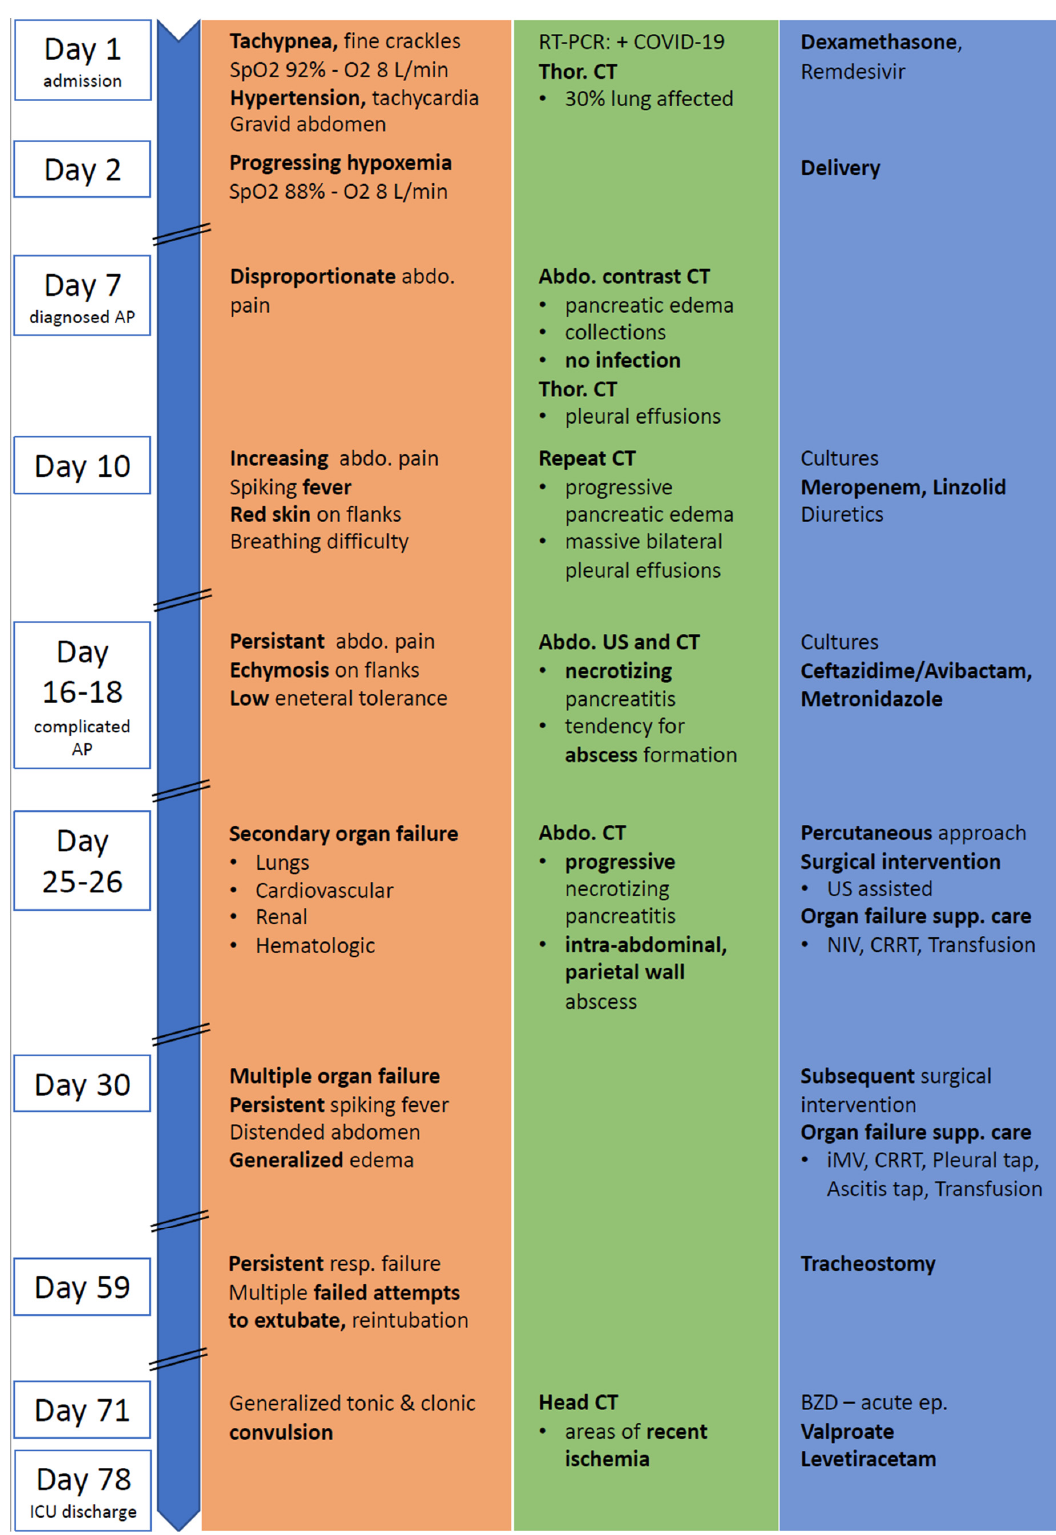
Figure 1. Event timeline from admission to hospital to discharge from intensive care. CT: computer tomography; Abdo: abdominal; Thor: thoracic; AP: acute pancreatitis; US: ultrasound; NIV: noninva- sive ventilation; iMV: invasive mechanical ventilation; CRRT: continuous renal replacement therapy; BZD: benzodiazepines; orange represents clinical presentation; green represents lab and imaging investigations; blue represents